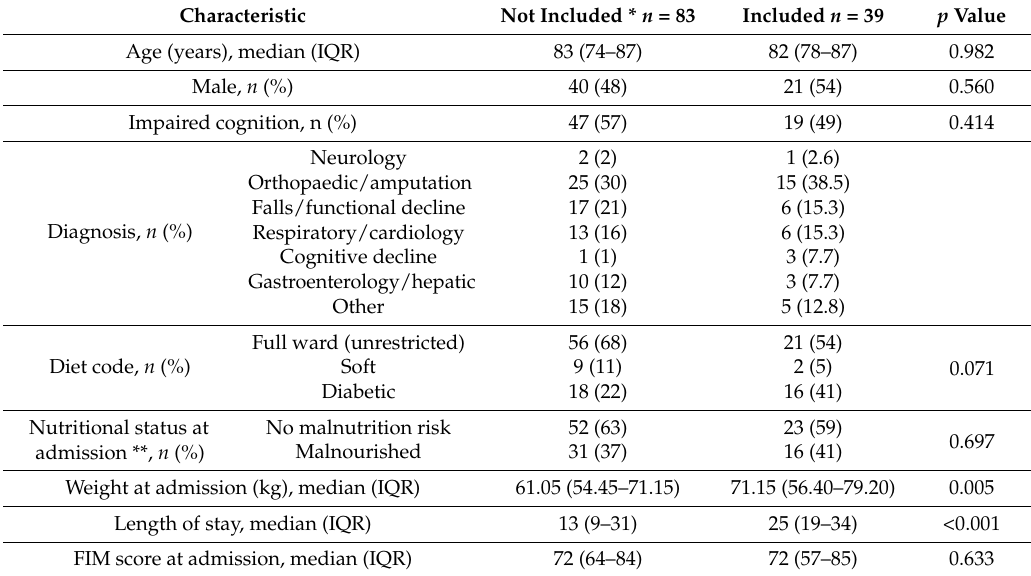
Table A1. Comparison of demographic characteristics of recruited study participants included in analyses and not included in analysis of change in intake between admission and day